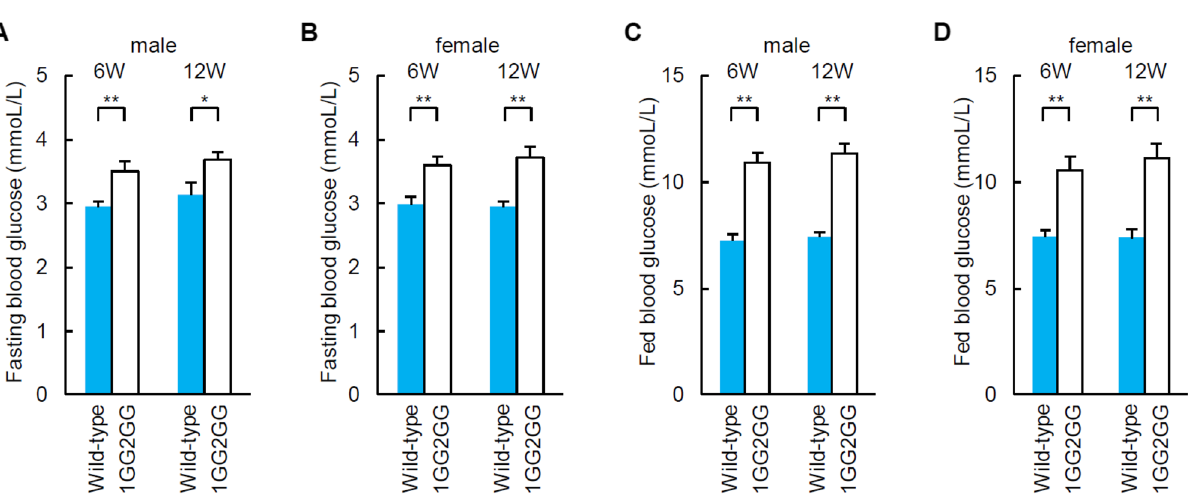
Figure 4. Blood glucose levels of 1GG2GG mice. ( A , B ) Fasting blood glucose concentrations of wild-type (n = 6) and 1GG2GG mice (n = 6) at 6 and 12 weeks of age [( A ): male, ( B ): female]. ( C , D ) Blood glucose levels of fed wild-type (n = 6) and 1GG2GG mice (n = 6) at 6 and 12 weeks of age [( C ): male, ( D ): female]. * p < 0.05. ** p < Immunohistochemistry of the pancreatic tissue of 1GG2GG mice. Immunohistochemical analysis of the pancreatic tissue of both 1GG2GG male and female mice showed reduced insulin expression in islets compared with what was observed in the islets of wild-type C57BL/6 mice (Fig. 3). Blood glucose levels of 1GG2GG mice. Fasted blood glucose levels of both male and female 1GG2GG